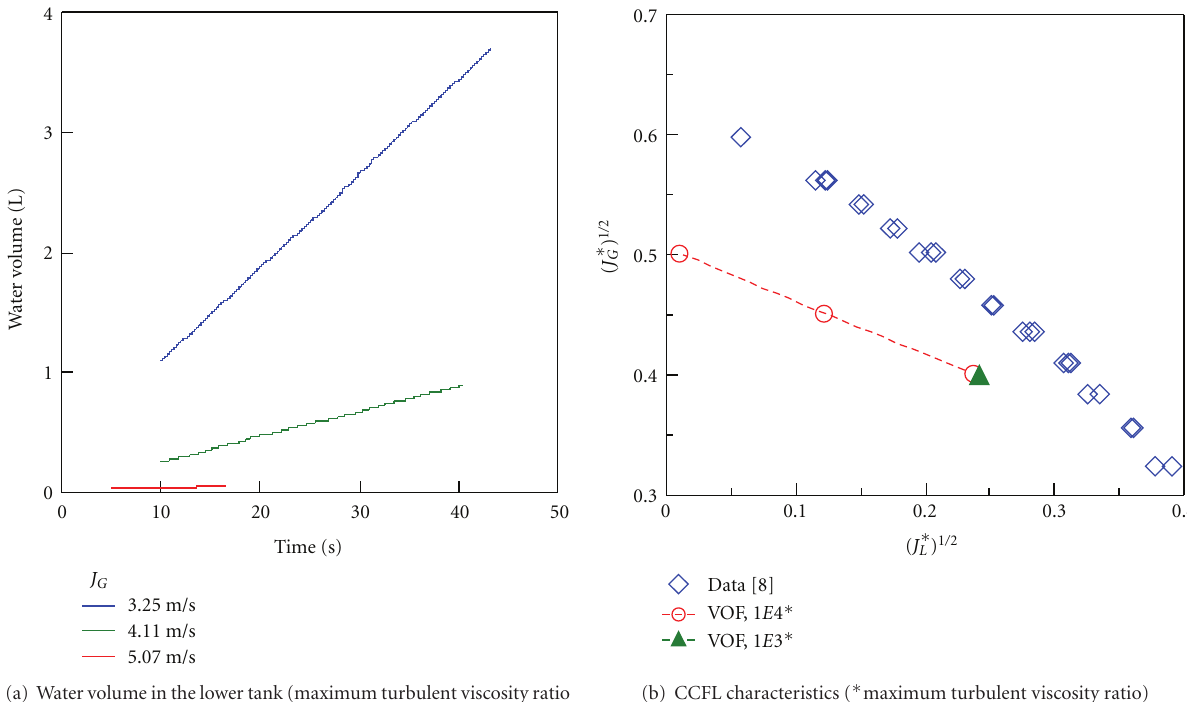
Figure 7: Results calculated using the standard k − ε turbulent model for the 1/5-scale tests ( D = 50 mm, air-water).